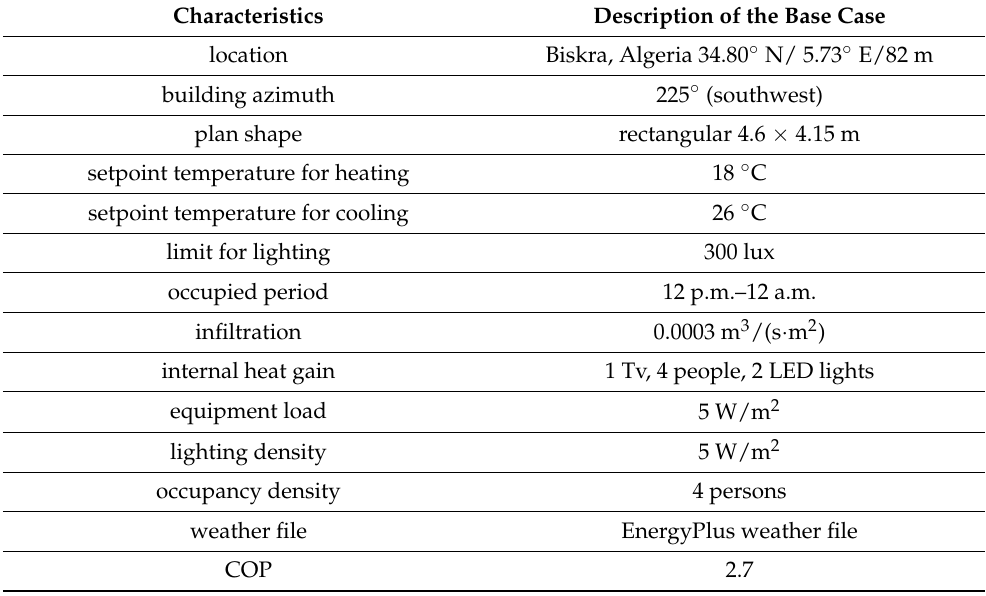
Table 4. Boundary conditions for the base